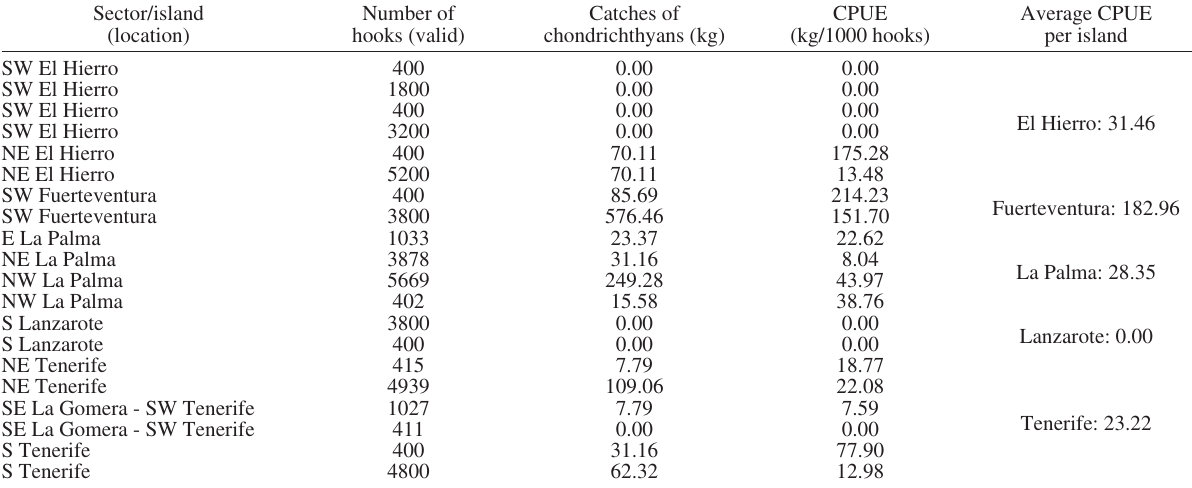
Table 2. – Catches of chondrichthyans and CPUE values per fishing operation (location), with an average CPUE per island. CPUE expressed in kg (total weight) per 1000 hooks. Sector/island